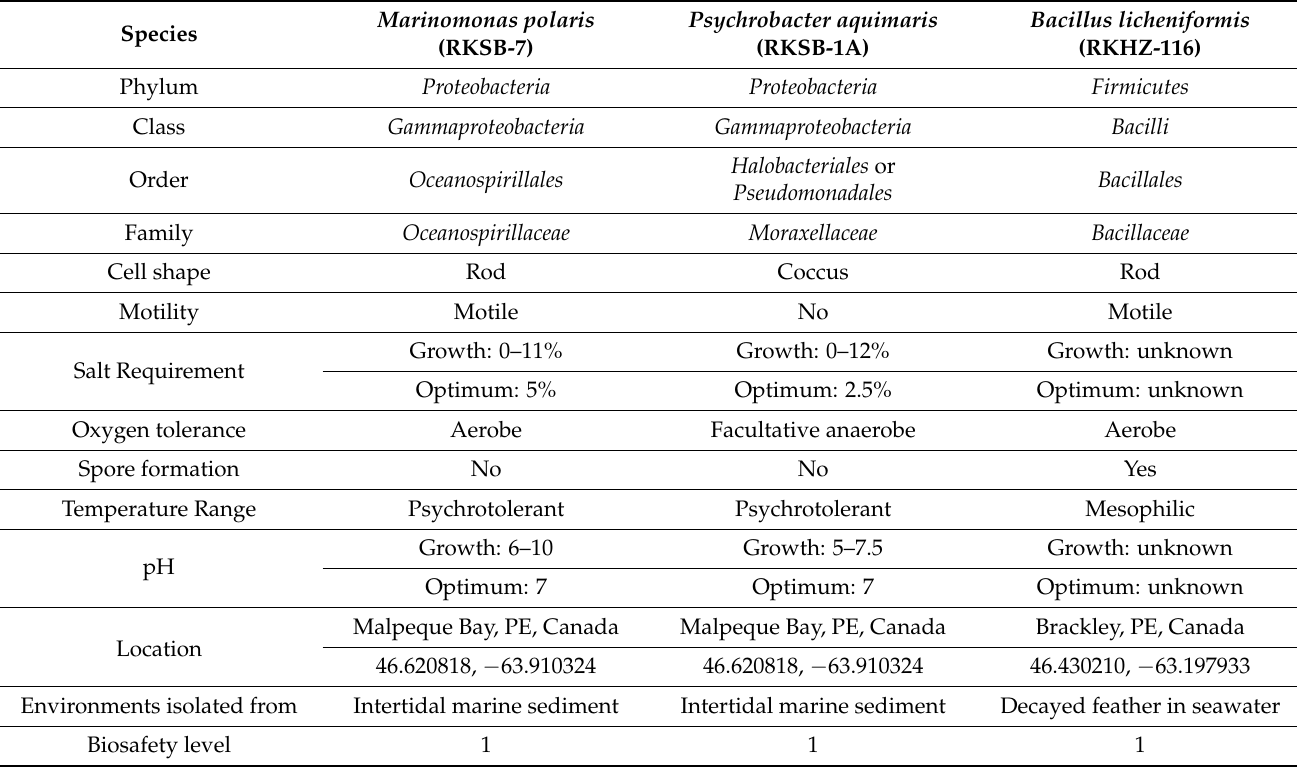
Table 1. Characteristics of three bacterial species isolated from marine habitats in Prince Edward Island, Canada